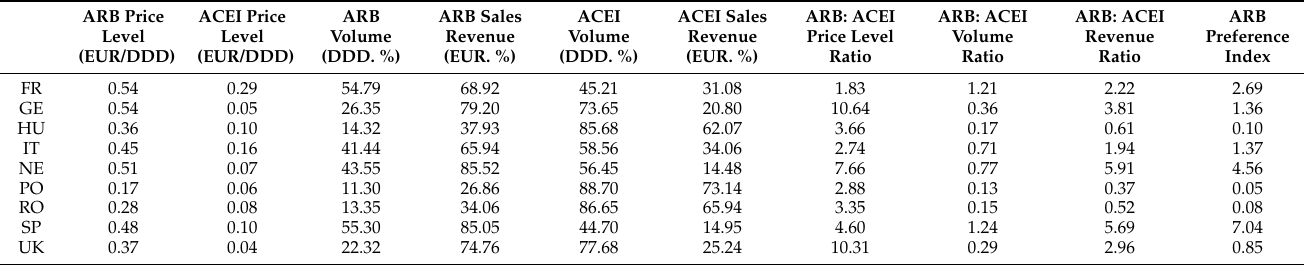
Table 2. Market features of ARBs and ACE inhibitors in 2009 based on DDD-adjusted volumes, taking into consideration combination drugs and single-drug